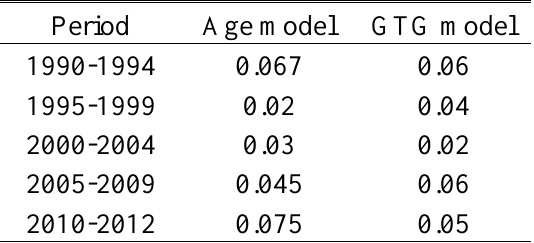
Table A2.3. Estimates of monthly exploitation rate from the age-structured model with A km 2 , compared to estimates from fitting the growth type group model to the average legal size distribution over 5-year